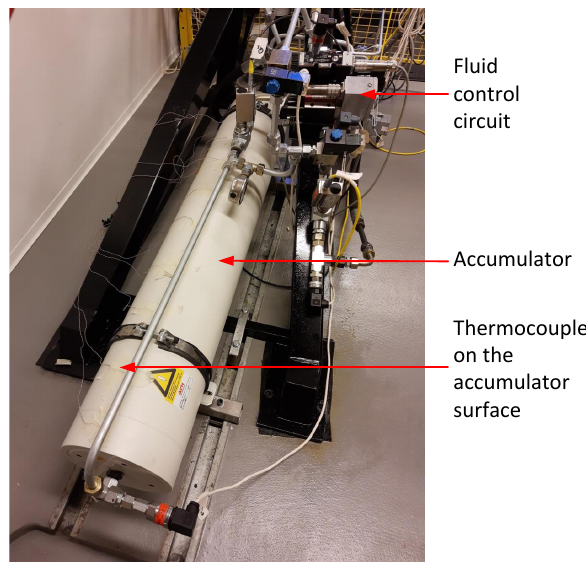
Figure 5. Test bench used to generate experimental data.